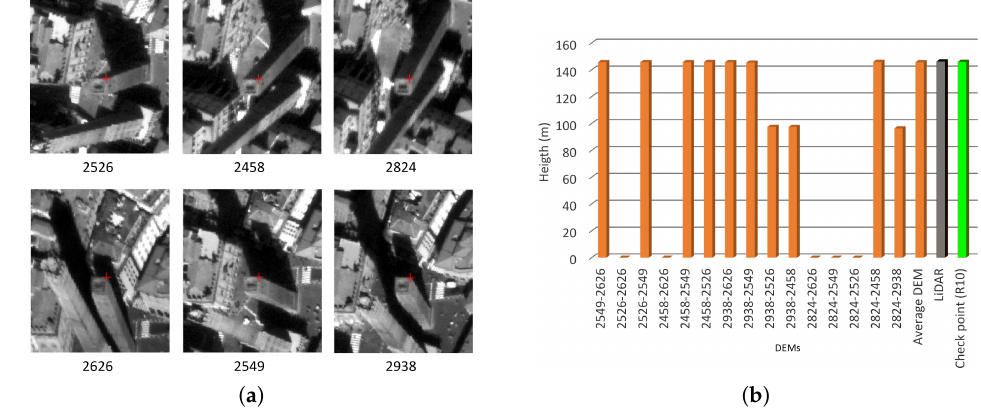
Figure 5. Statistics on the check point residuals for the DEMs derived from each pair and for the Average DEM. Box limits are the first and third quartiles, while the band inside is the median. Whiskers represent the 5th and 95th percentiles.